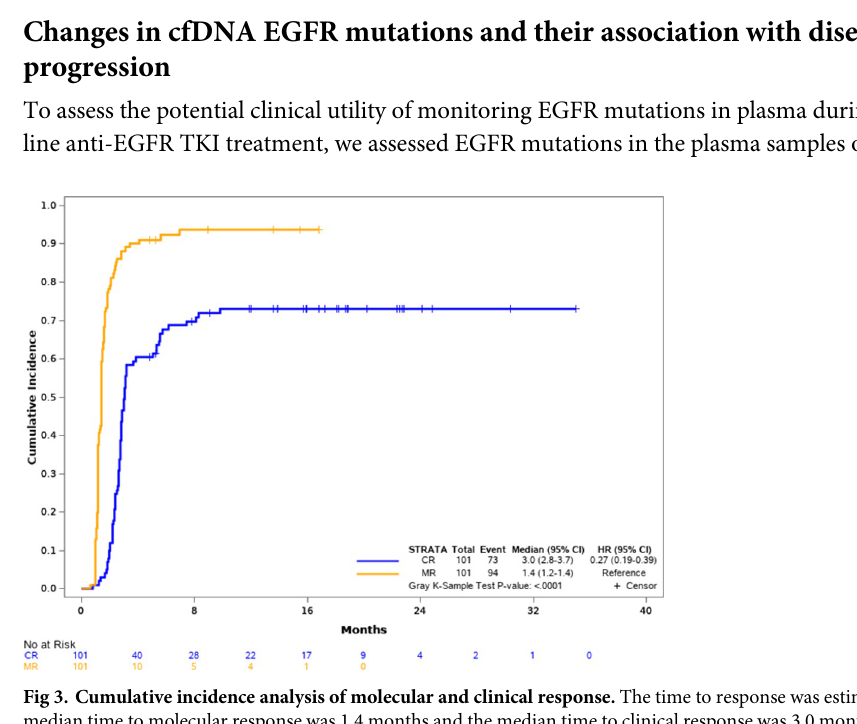
Fig 3, the median time to molecular response was 1.4 months and the median time to clinical response was 3.0 months. Molecular response was highly predictive of clinical response as 69/73 (95%) patients who had a clinical response also had a molecular response. In those patients who did not have a molecular response (n = 7), none had a clinical response.